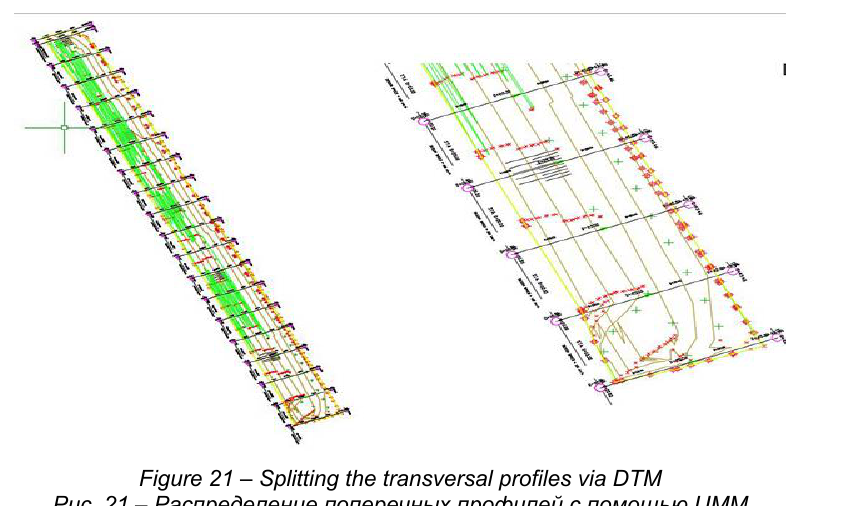
Figure 21 – Splitting the transversal profiles via DTM Рис . 21 – Распределение поперечных профилей с помощью ЦММ Слика 21 – Распоређивање попречних профила преко